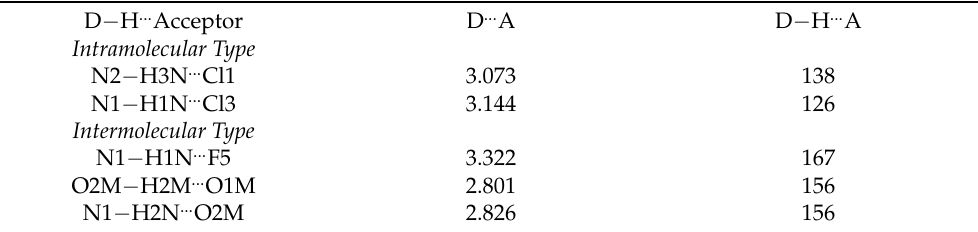
Figure 2. ORTEP (30% probability ellipsoids) of the molecular structure of [{RuCl( η 6 - p- cymene)} 2 ( μ - Cl)( μ -1- N , N ´-naphthyl)] + ; and ( 2a ) in two different perspective views. Carbon-bonded hydrogen atoms are omitted for clarity. Dashed lines refer to intramolecular N − H ... Cl hydrogen bridges. Table 2. Selected bond lengths (A) and angles ( ◦ ) of the hydrogen bridges formed by 2 · 2MeOH in the solid